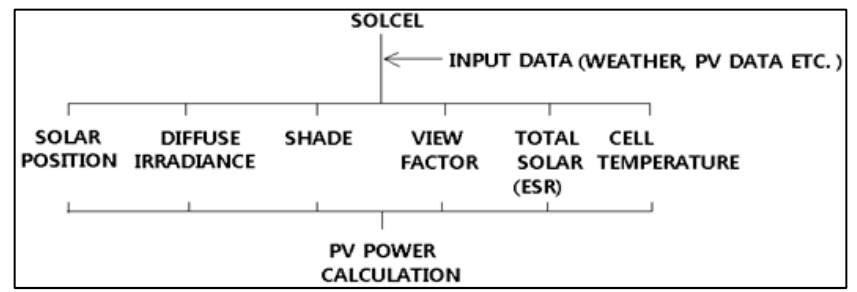
Figure 1. The structure of the simulation program SOLCEL.